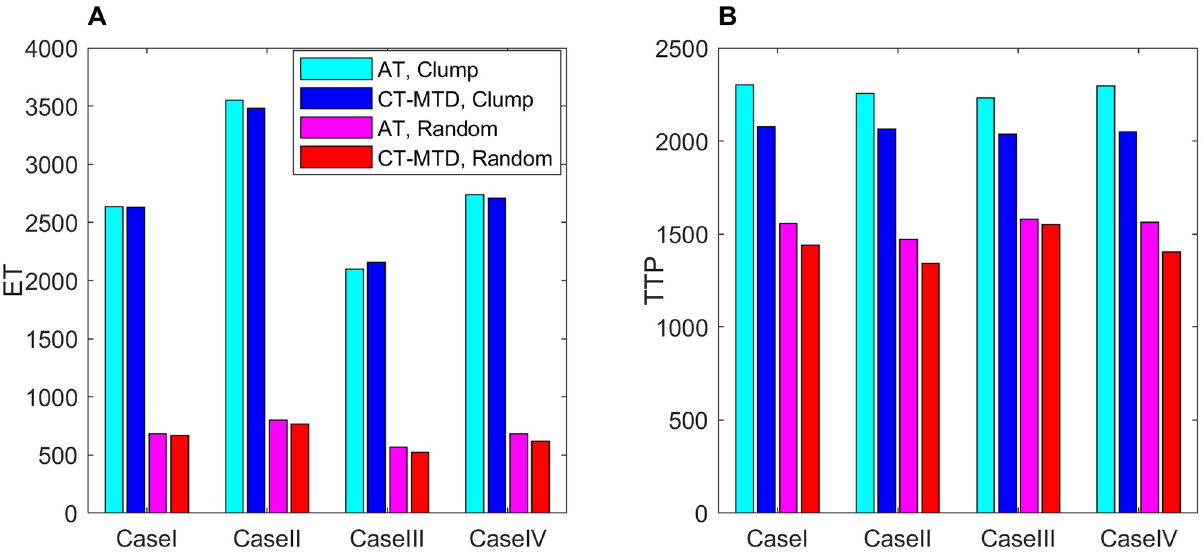
Fig 17. Bar chart of the ET and TTP under CT-MTD and AT for Cases I to IV. ( A ) clumped invisible metastases, ( B ) random invisible metastases.